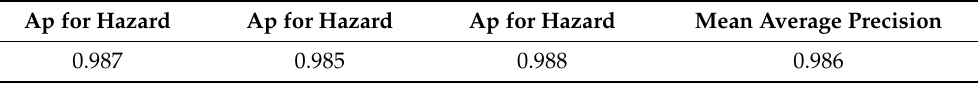
Table 3. Recognition average precision (AP) for di ff erent objects.